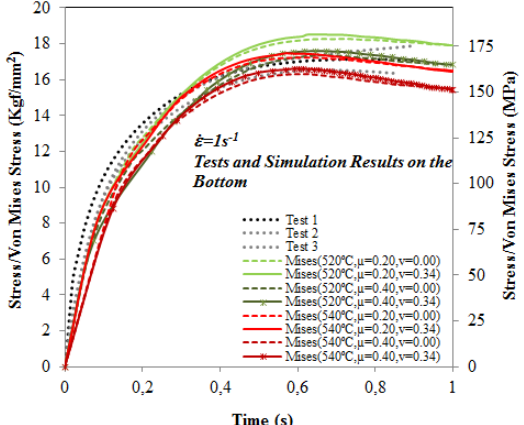
Figure 10 are the Von Mises stress vs. Time curves on the bottom of the sample. The experimental stress (gray dotted lines) also was calculated taking into account the Dieter friction correction 19 and the Torrente friction correction 20 .